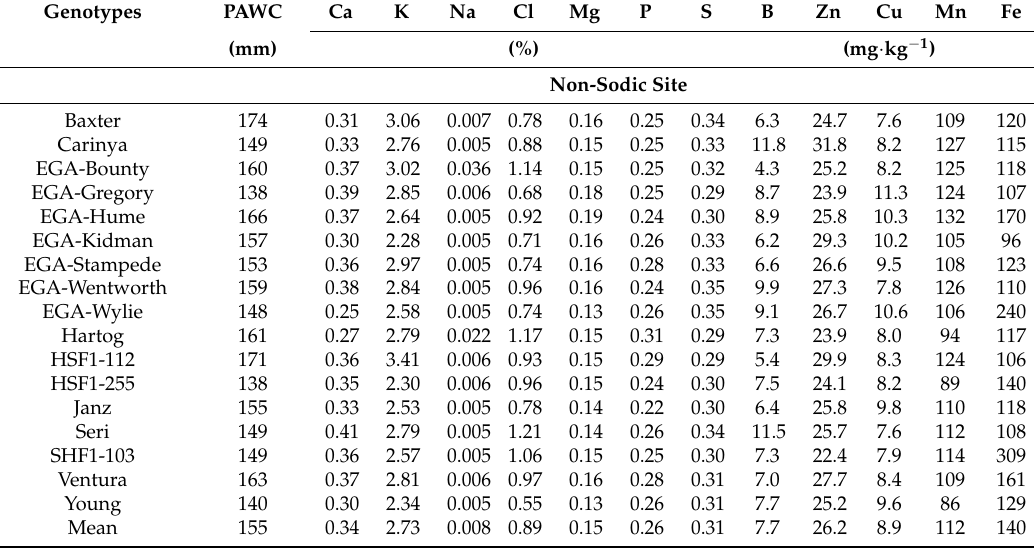
Table 4. Plant available water capacity (PAWC) and nutrient concentrations in wheat genotypes grown at a non-sodic site and sodic site in